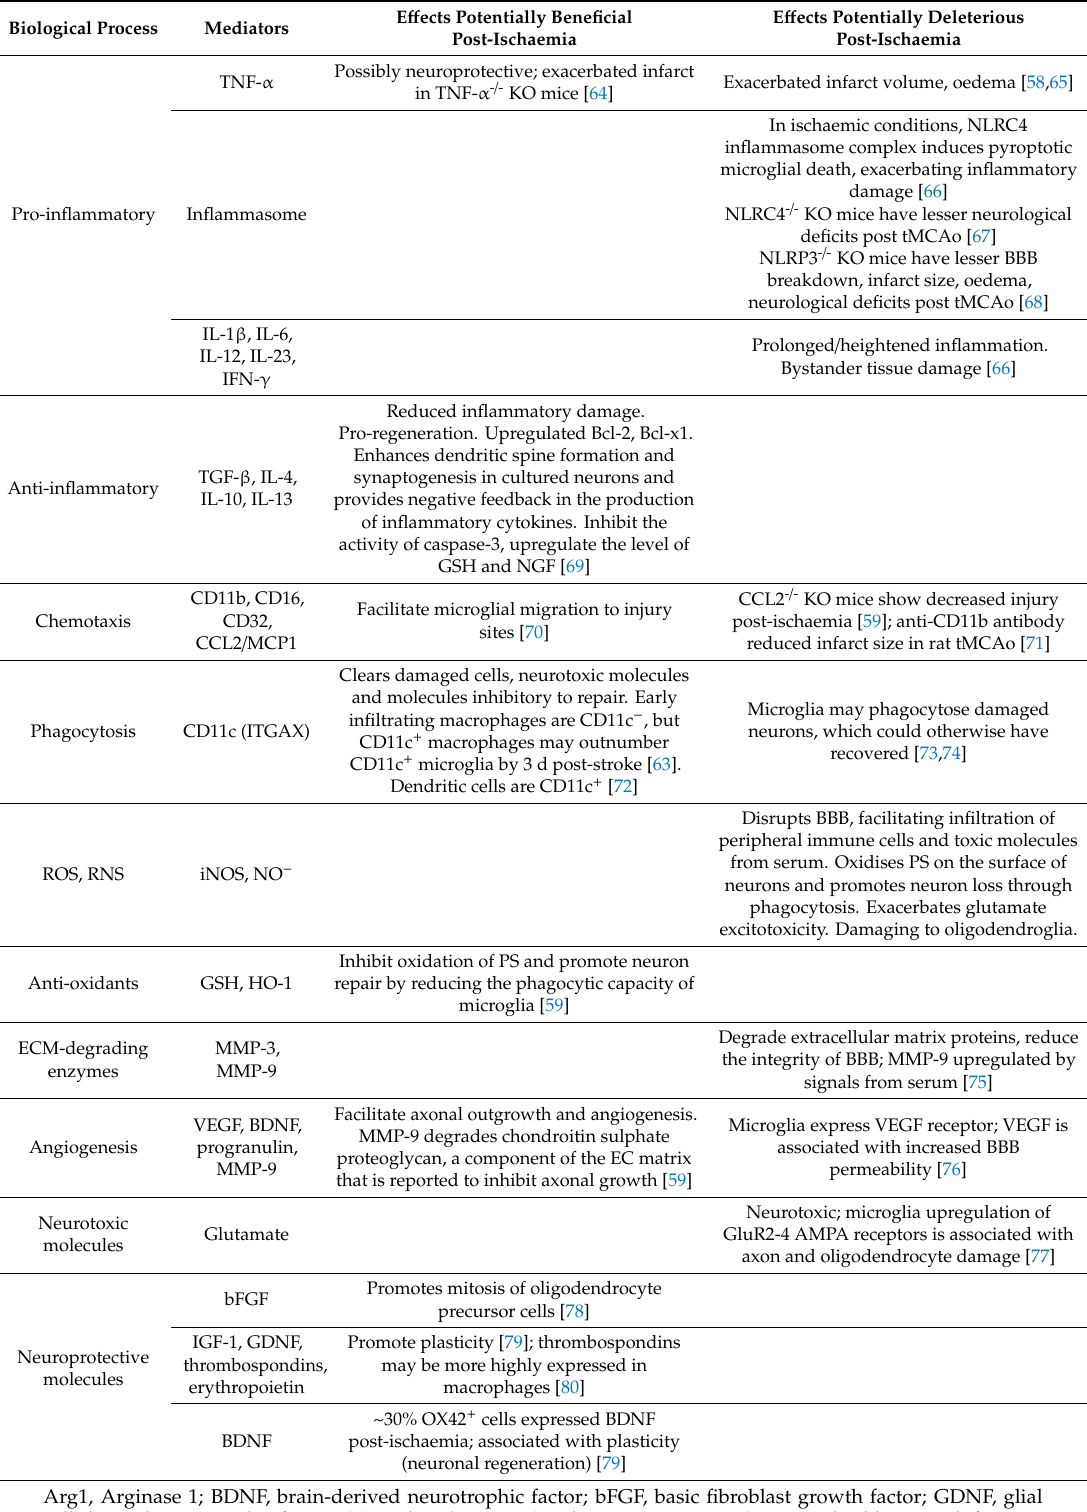
Table 1. Roles of Microglia in Ischaemic